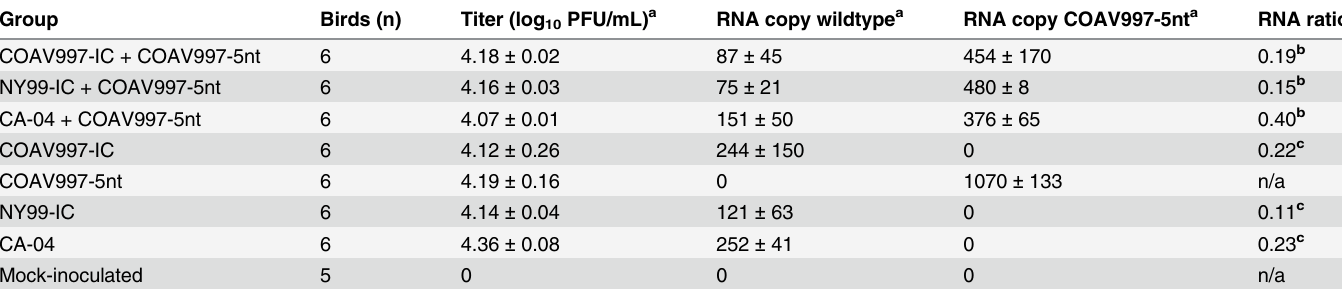
Table 1. Viral titer and RNA copy numbers from HOFI inocula and relative RNA input ratios between groups. Group Birds (n)